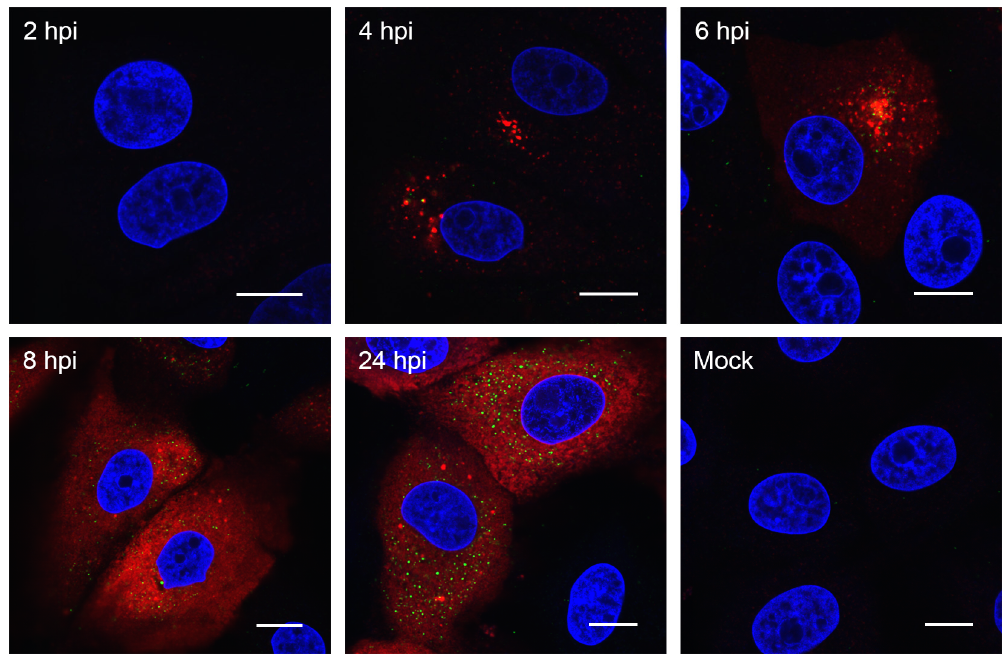
Figure 2. PDCoV-associated dsRNA can be detected from 4 hours post-infection (hpi). LLC-PK1 cells were infected or mock-infected. At the stated timepoints, cells were fixed and labelled with anti-dsRNA (green) and anti-N (red). Nuclei were stained with DAPI (blue) and scale bar indicates 10 μ m. Images are representative of three independent replicates.